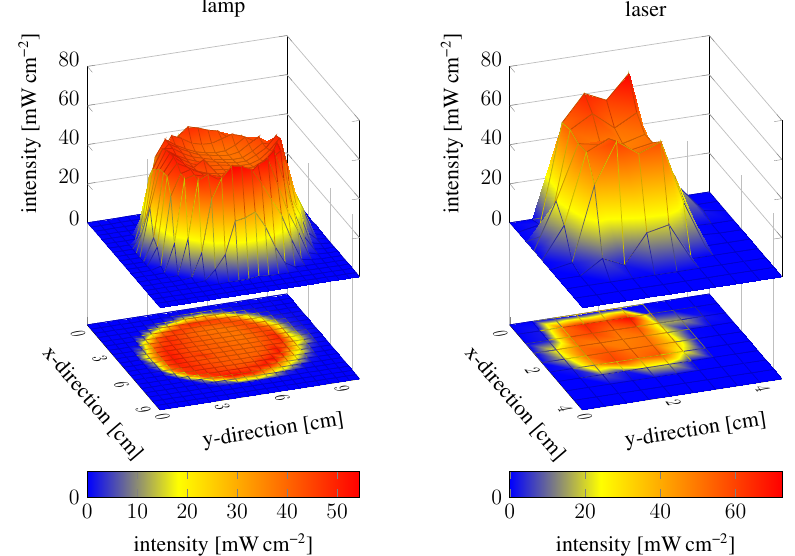
Figure 4. Intensity field distribution of the mercury-vapour lamp and the laser. Measurements were conducted at a distance of 0.5m for the lamp and 1.5m for the laser. If the polymerisation solution is filled in the NMR tubes under standard conditions, the polymerisation 189 process needs higher exposure times (see Figure 3). For the experiments conducted with the lamp, 190 the required exposure time for the gel polymerisation was 30s and for the laser 25s. This and also 191